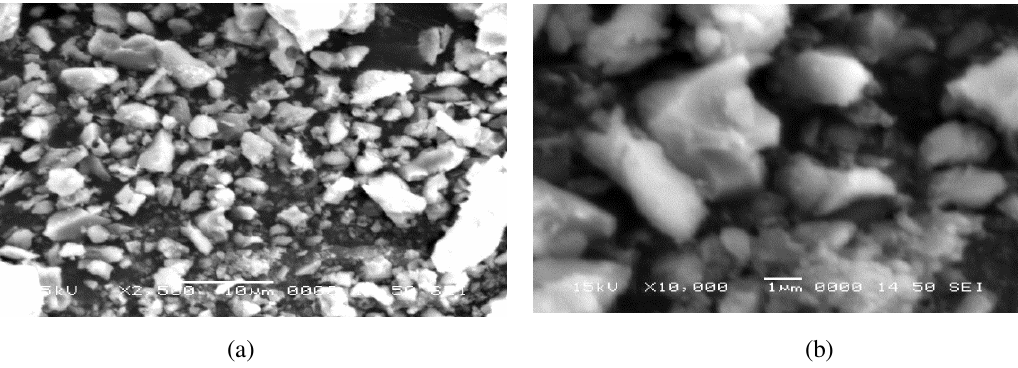
Fig. 5: Surface Morphology prepared HAP Powder: (a) Magnification of ×2500 (b) Magnification of